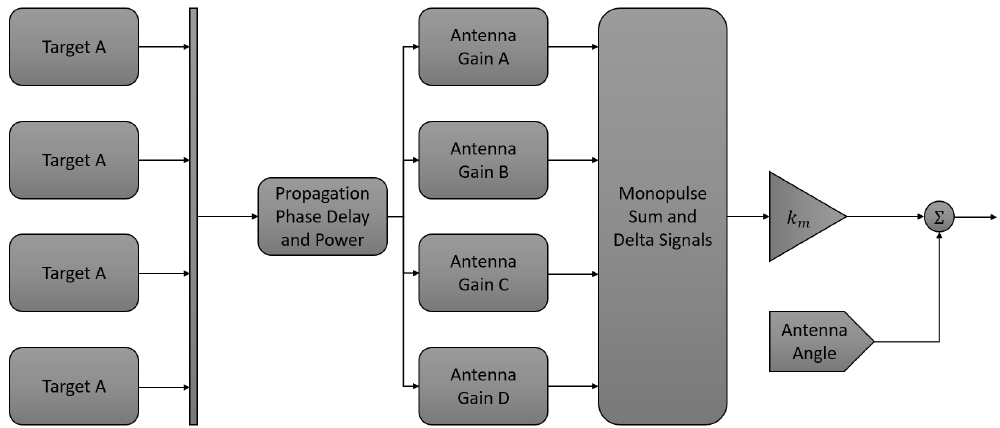
Figure 9. The Simulink model for the monopulse receiver, with the analog and testbed components implemented in Simulink and the digital systems on an FPGA.